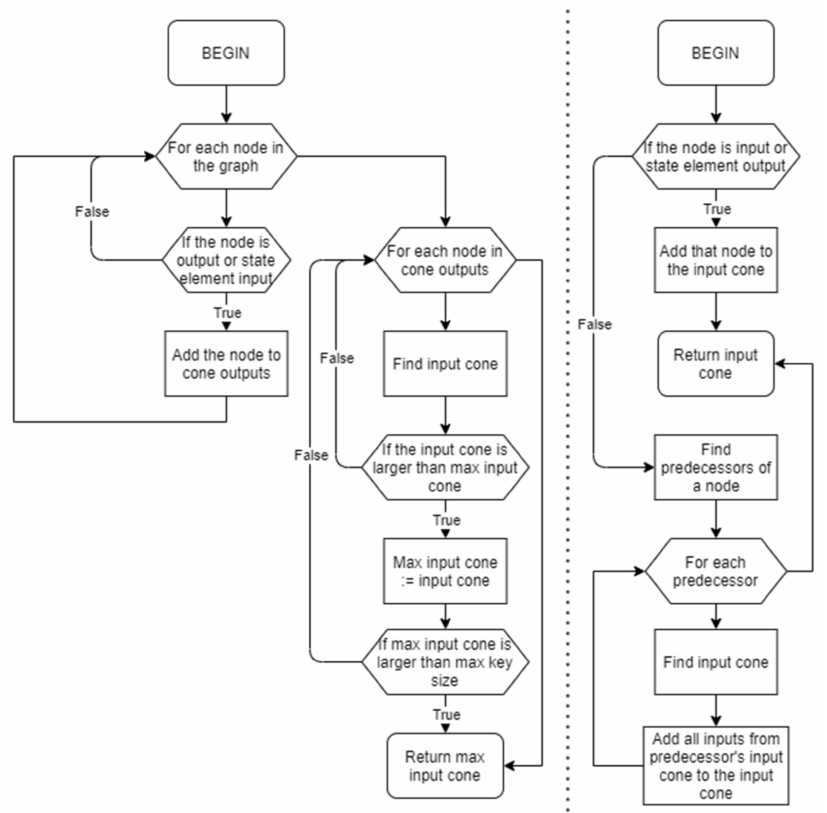
Figure 4. The algorithm for finding a maximum input cone ( left ) and an input cone for a single node ( right